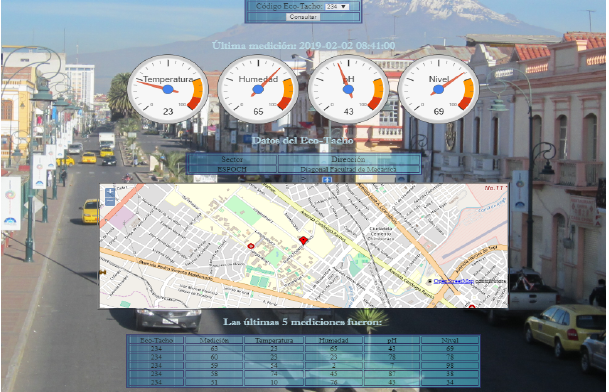
Figure 9. Parameter measurement page.